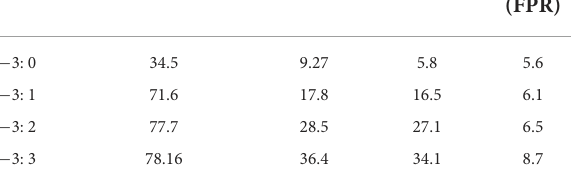
TABLE 2 The percent of individuals predicted as having COVID-19 by the Bayesian network run over an increasing number of